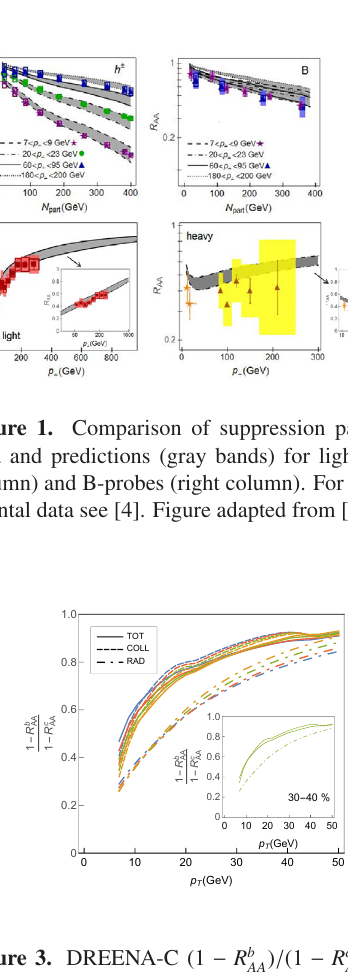
Figure 3. DREENA-C (1 tal (full), collisional (dashed) and radiative (dot- dashed curves) cases for centralities (as in Fig. 4 legend) are displayed. For clarity, 30 trality is singled out. Figure adapted from [11].